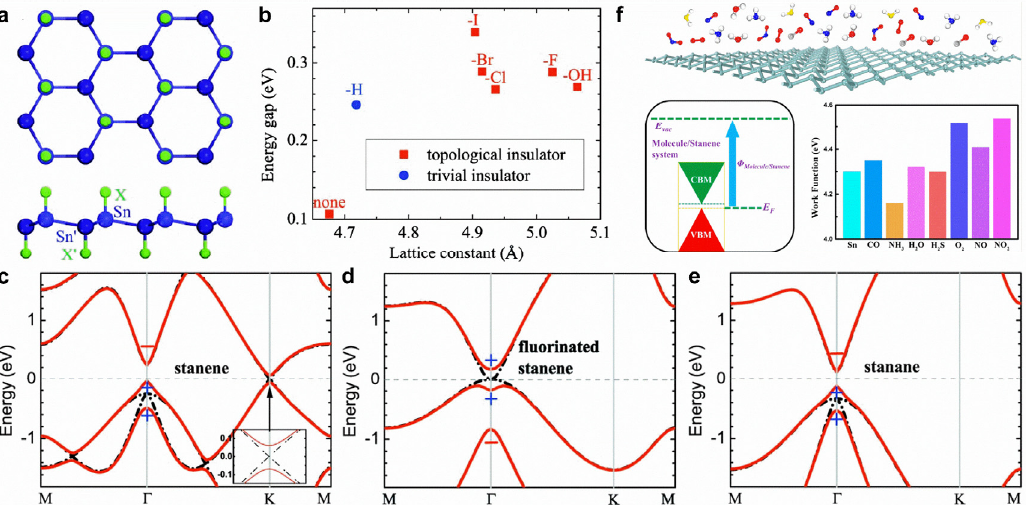
Figure 9. Surface modifications of stanene. ( a ) Crystal structure of decorated stanene by hydrogen or halogen atoms on both sides. ( b ) The calculated energy gaps of stanene and decorated stanene. ( c – e ) Band structures for ( c ) stanene, ( d ) fluorinated stanene, and ( e ) stanene with (red solid lines) and without (black dash-dotted lines) SOC. Parities of the Bloch states at the Γ point are denoted by +, − . ( f ) Structural model of stanene for the adsorption of various molecules and work function of stanene with various adsorbed molecules. ( a – e ) Reprinted with permission from Ref. [155]. Copyright 2013, American Physical Society. ( f ) Reprinted with permission from Ref. [157]. Copyright 2016, American Chemical